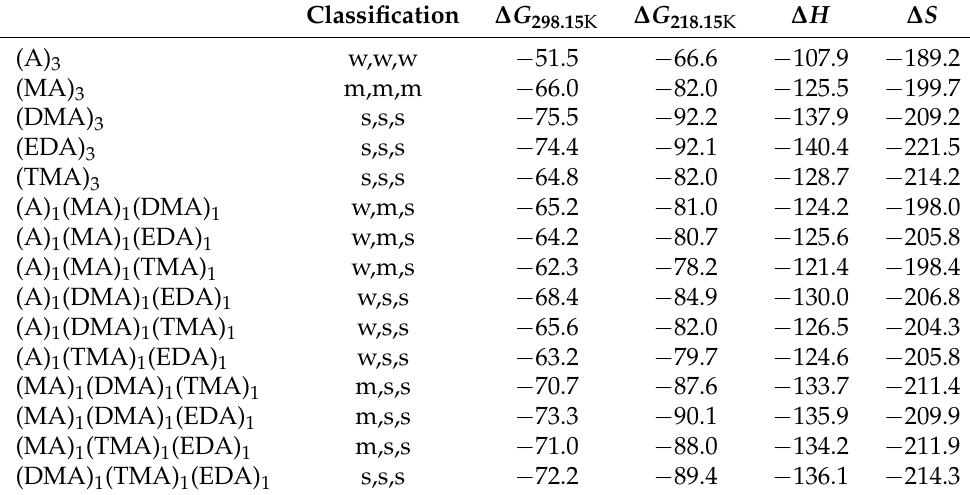
Table 1. Calculated binding free energies (at 298.15/218.15 K, 1 atm) of the (SA 3 )(base) 3 clusters at the DLPNO-CCSD(T 0 )/aug-cc-pVTZ// ω B97X-D/6-31++G(d,p) level of theory using the quasi- harmonic approximation. ∆ G 298.15K , ∆ G 218.15K and ∆ H are in kcal mol − 1 . ∆ S are in cal mol − 1 K − 1 . The classifications refer to the base strength, with w = weak, m = medium and s =